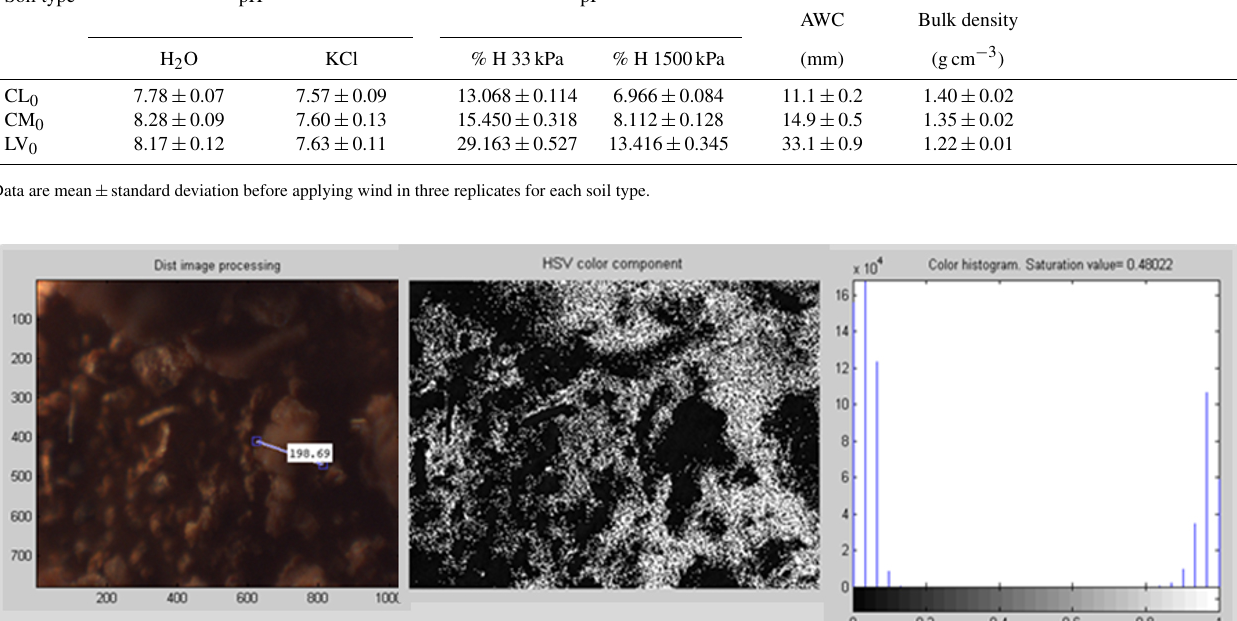
Surface stoniness of these soils is high and the aver- age gravel for the different typologies is 37 ± 7 % in CL, 48 ± 8 % in CM and 43 ± 5 % in